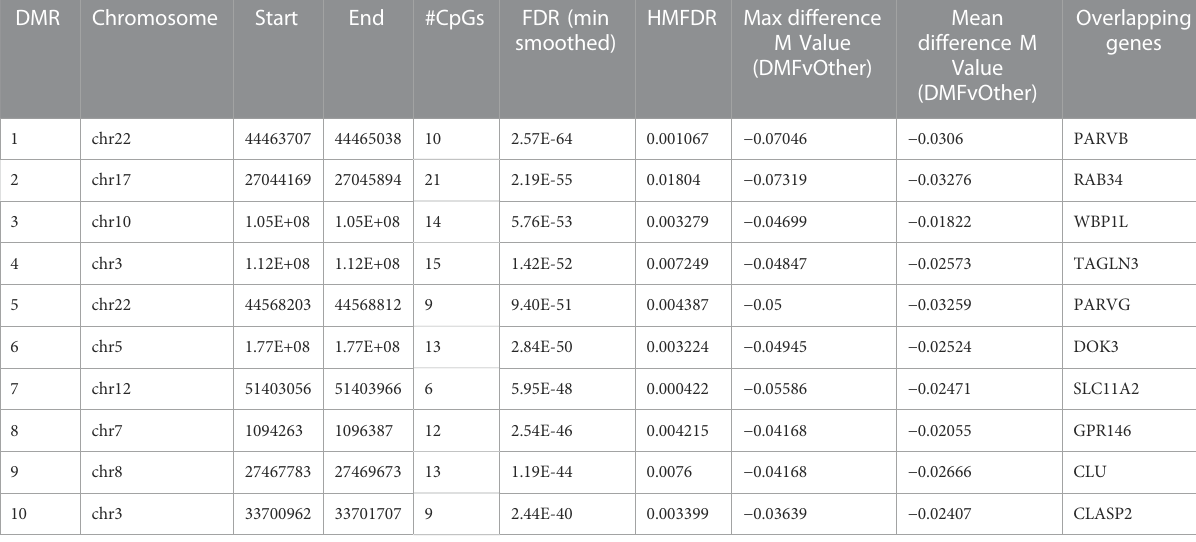
TABLE 8 Top 10 differentially methylated regions (DMR) associated with dimethyl fumarate